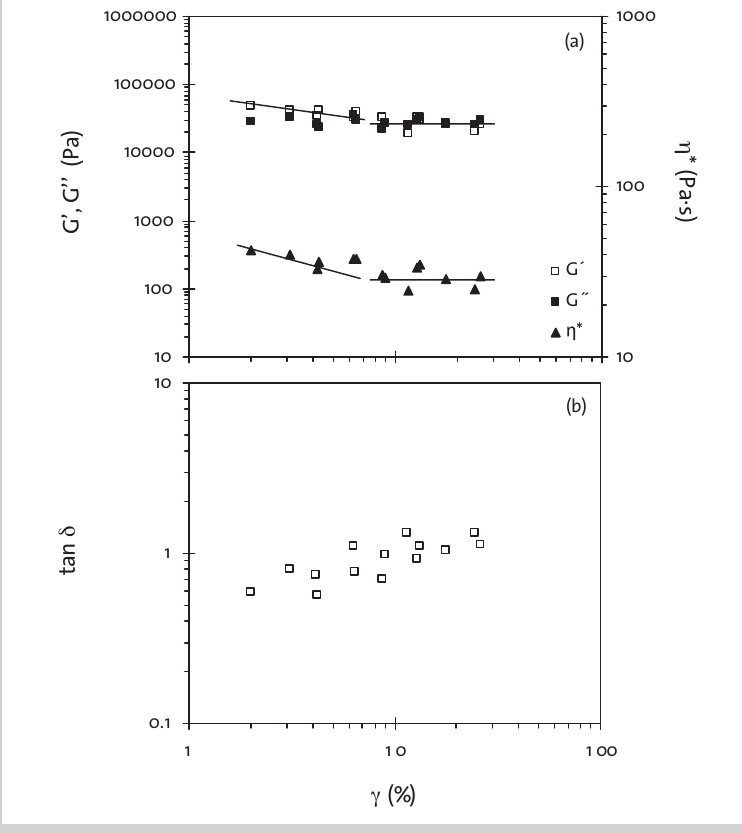
Figure 6 (left): A representative plot of the shear stress, s , and shear strain, g , as a function of time, t, for PDMS obtained on the HF-SPR (gap = 0.53 mm and ampli- tude = 0.0635 mm). Figure 7: a) Storage modulus , G’, loss modulus, G’’, complex vis- cosity, h *, and b) loss tangent, tan d , as a function of strain, g , for PDMS measured on the HF- SPR. Trend lines drawn to guide the